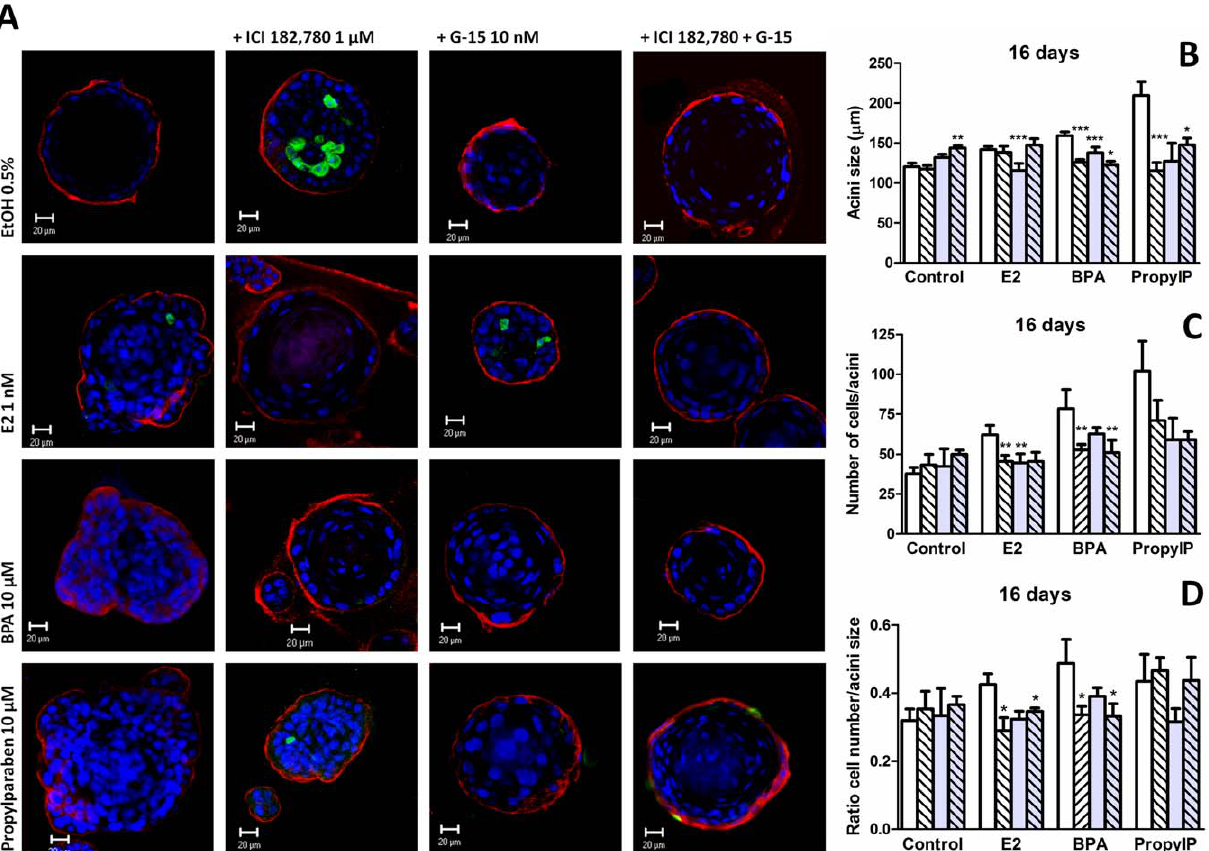
Figure 7. Impact of ER and GPER inhibitors on acini disruption by estrogens. Cells were treated with the test compounds (E2, 1 nM; BPA, 10 m M; propylparaben, 10 m M) alone or in combination with ICI 182,780 (1 m M), G-15 (10 nM) or ICI 182,780 (1 m M) + G-15 (10 nM) for 16 days. A Resulting acinar structures were immunostained as described before. Red shows laminin V and basement membrane deposition, green highlights apoptotic cells by staining activated caspase-3 and blue shows cell nuclei (TO-PRO 3 counterstain). Images were visualized by confocal microscopy and represent 3 experiments, run independently. B . Quantification of acinar size following treatment with estrogenic chemicals and inhibitors. White bars represent treatment with individual compounds. Hatched white bars show the effect of the chemicals in the presence of ICI 182,780 and grey bars of test compounds in combination with G-15. Grey hatched bars show the effect of the test chemicals when combined with ICI 182,780 + G-15. C . Number of cells per acini. D . Ratio cell number/acini size calculated for the samples shown in B and C. For all graphs, data results from three independent experiments (10 acini/experiment) and indicates mean 6 SEM. * (p , 0.05) and ** (p , 0.01) highlight significant differences between treatments with estrogenic agents tested individually and treatments with estrogens combined with